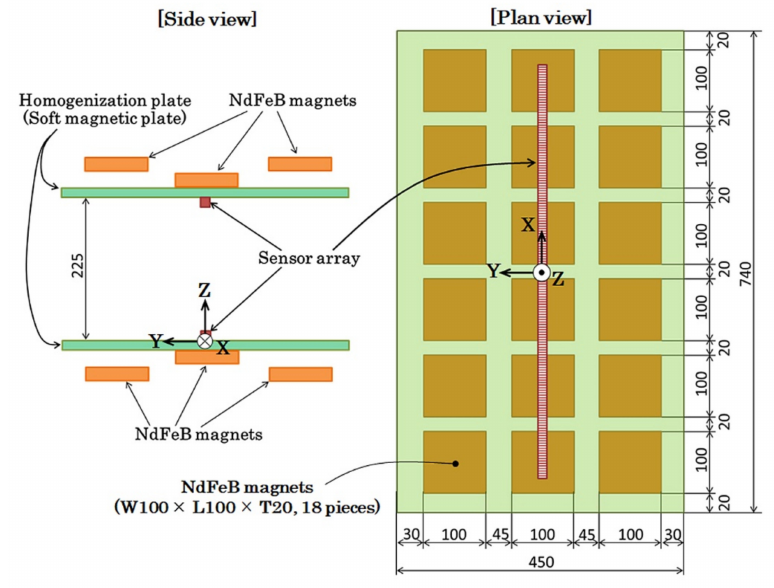
Figure 5. Design layout of the proposed field generation apparatus. (Unit: mm).